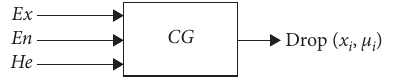
Figure 6: The forward cloud